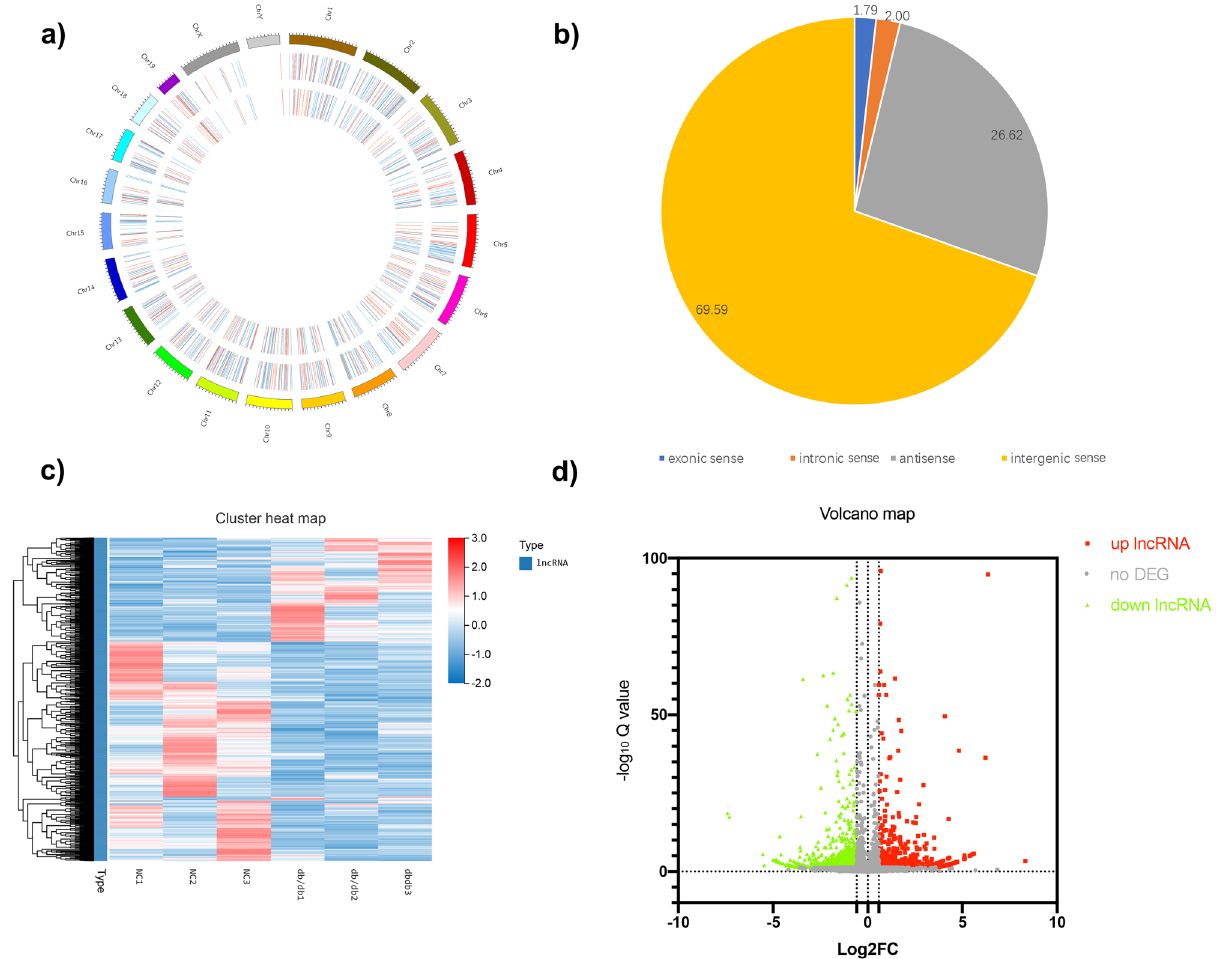
Fig. 3 Differentially expressed lncRNAs in db/db vs. db/m . a Circus plots showed dif-lncRNAs on mouse chromosomes for db/db vs. db/m . The outer circle is the chromosome, the second circle is all the differential dysregulated lncRNAs, and the inner circle is the signi fi cantly dif-lncRNAs (|log 2 FC | > 1 q-value < 0.05). b Pie charts showed the percentage of four types (exonic sense, intronic sense, antisense, intergenic sense) of dysregulated lncRNAs in db/db mice and the controls. c The cluster heatmaps and d scatter plots showing the dif-lncRNAs in db/db and db/m mice, respectively ( n = 3). Note: dif- lncRNAs: differentially expressed